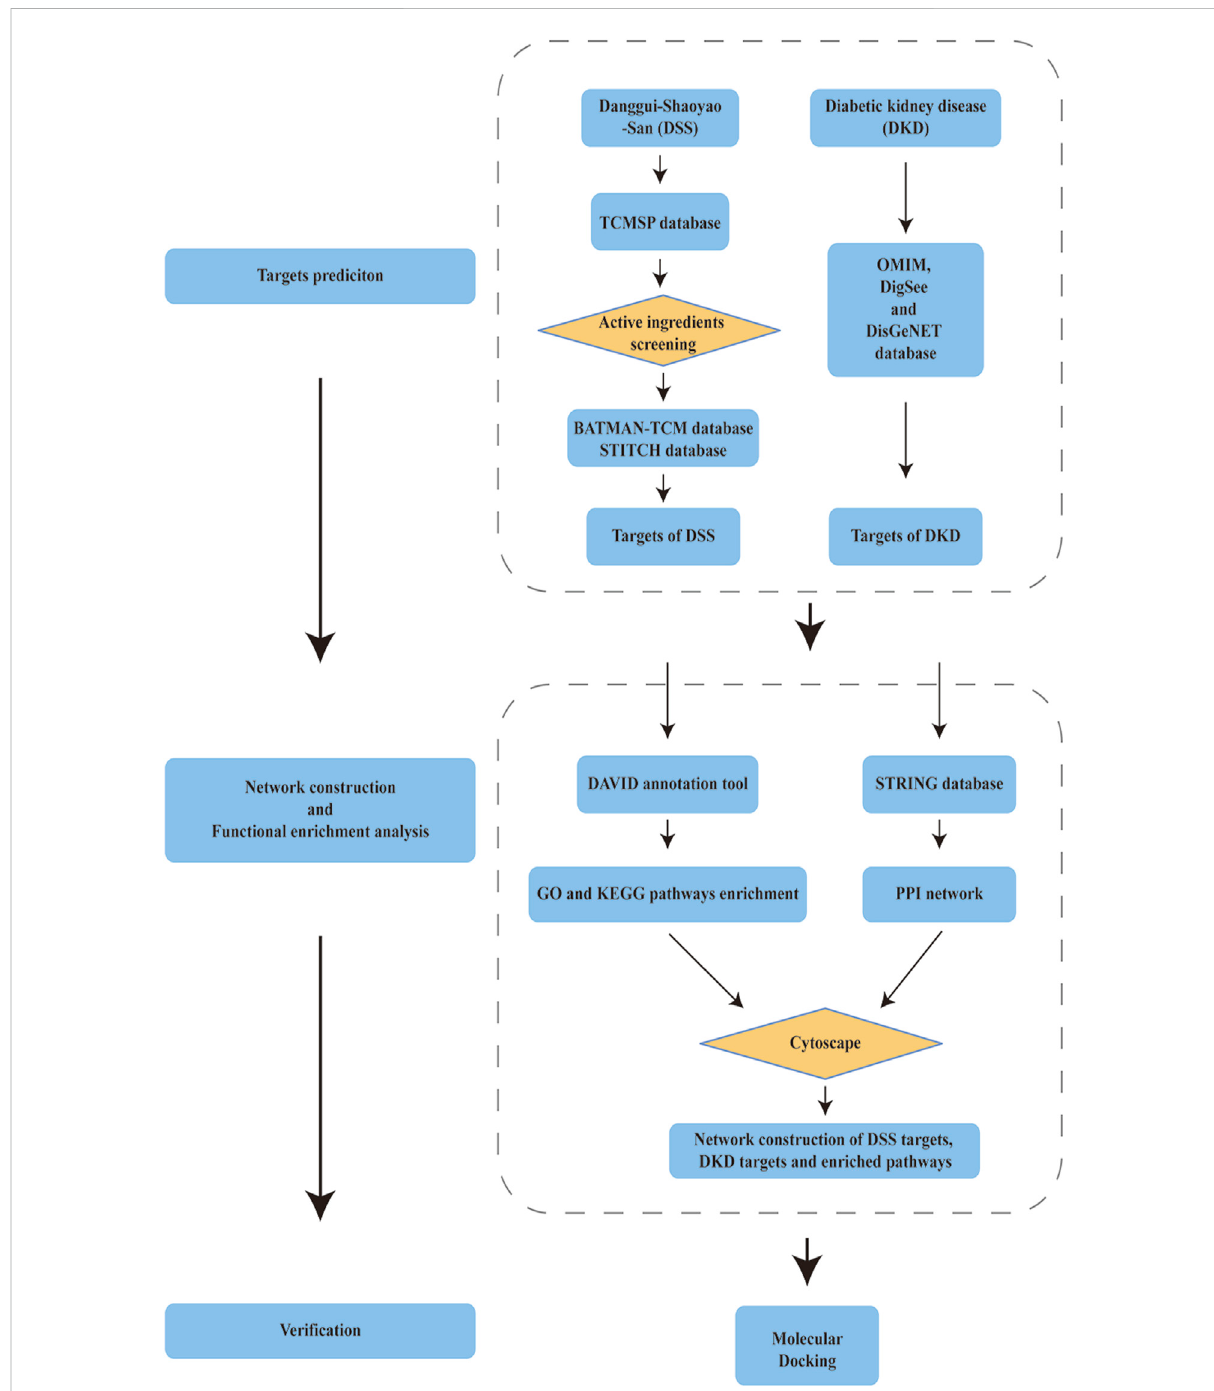
FIGURE 1 Schema of network pharmacology analysis of Danggui-Shaoyao-San (DSS) against diabetic kidney disease